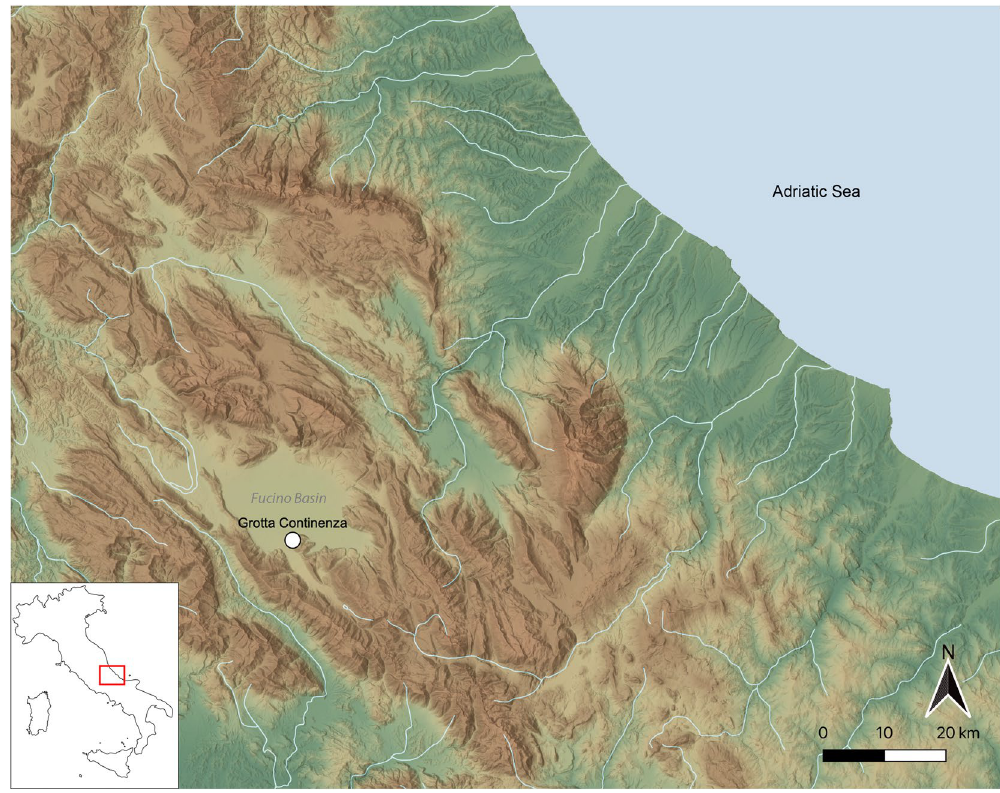
Figure 1. Location of Grotta Continenza in the Fucino Basin